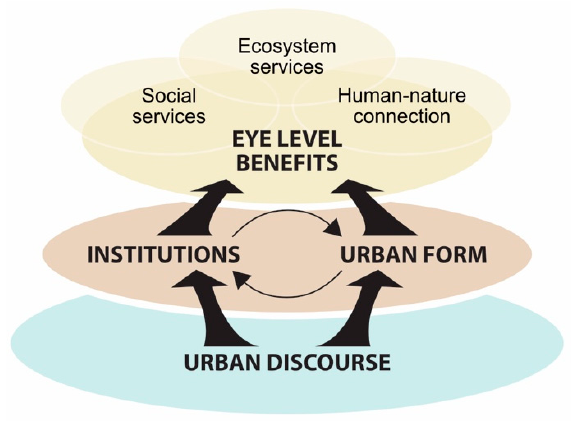
Figure 2. A conceptual outline of SEU. On the SEU view, institutions and urban form, both shaped by urban discourse, interplay to create the conditions for social–ecological outcomes. Spatial and social processes in cities are not separate, and urban form should thus be seen as a socio-spatial system. SEU highlights the eye-level benefits, such as social services, ecosystem services, and cognitive resilience building, but also stresses that these eye-level benefits are embedded in a larger systemic context.